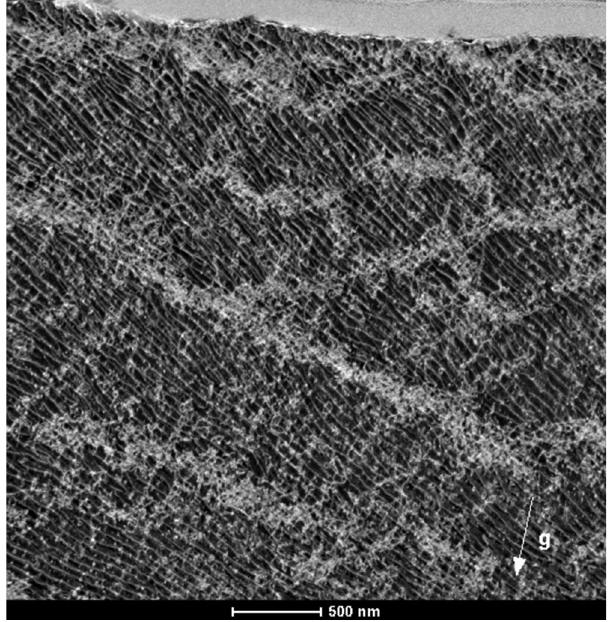
FIG. 4. A dark-field STEM image of a cross-sectional lamella from a fully conditioned (see main text) OFHC soft Cu electrode, under two-beam g:111 diffraction conditions, showing disloca- tion cells separated by dislocation walls. The cross section was taken from a region far (at least 50 μ m away) from any break- down site. The dislocation walls appear as curled thin bright lines, as opposed to long straight dislocation segments inside the cells which are organized in a ladderlike